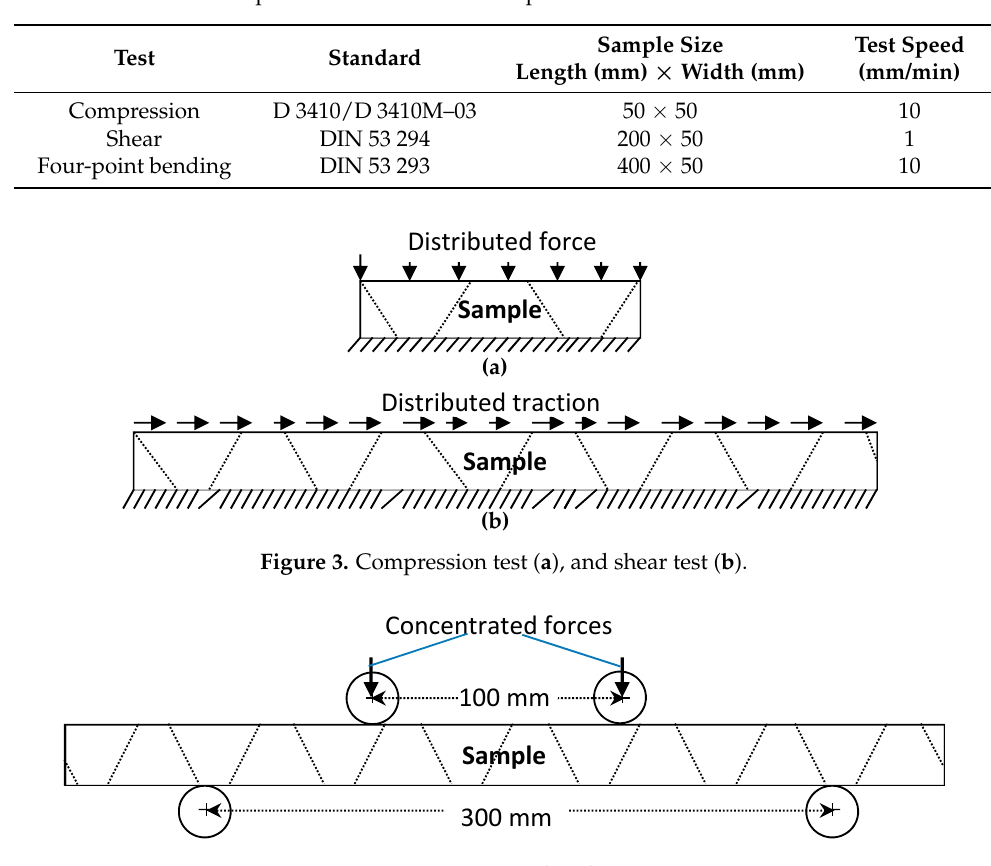
Table 1. Experimental data for P2-8 nap-core sandwich mechanical tests.